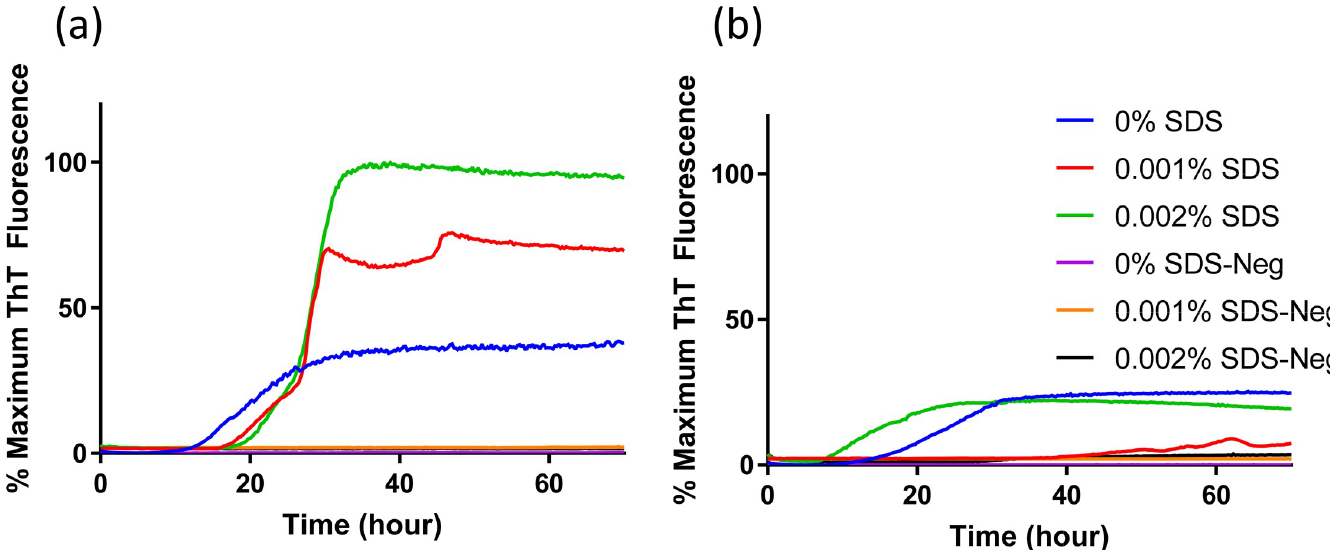
Fig 4. Comparison of SDS dependency of RT-QuIC reactions using mature (a) elk prion protein 132L or (b) 132M as substrates. RT-QuIC reactions were seeded with 10 − 2 dilutions of scrapie-infected sheep (animal #3) and negative control (uninfected sheep) brain homogenates using either mature elk prion protein 132L or 132M protein (aa 23–231) as substrates without SDS (blue line), with the addition of 0.001% (red line) or 0.002% SDS (green line) in the presence of 400 mM NaCl. Data are presented as mean ThT fluorescence of 4 technical